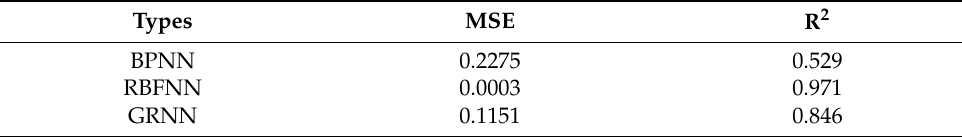
Table 3. The result of ANNs.